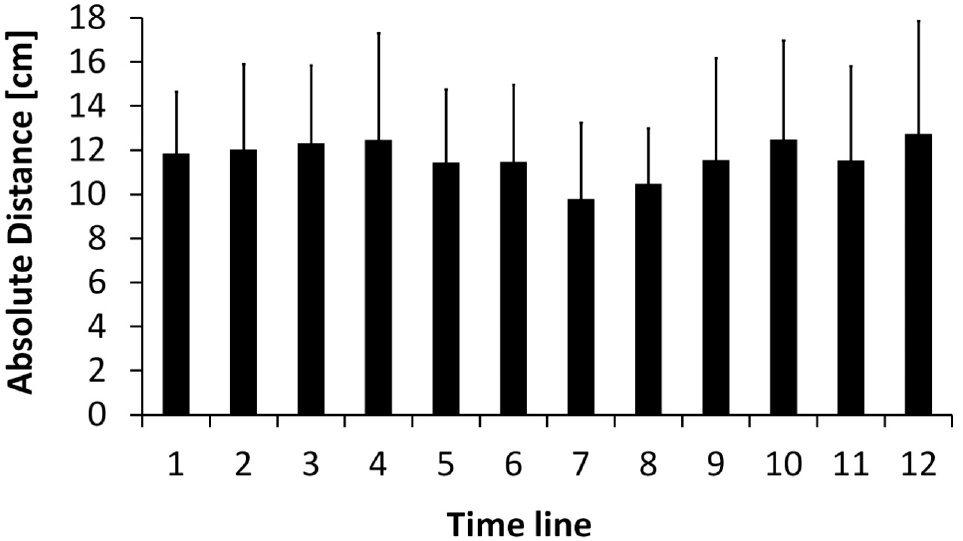
Figure 5. Time course of average absolute distance for the 12 blocks.